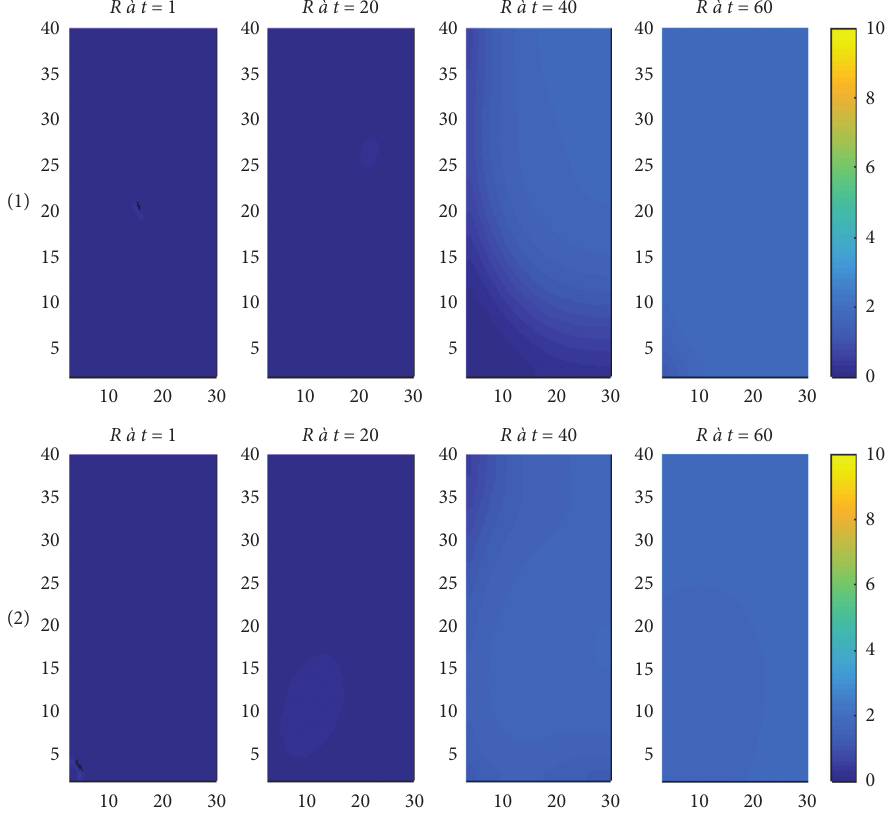
Figure 4: Recovered behavior within Ω without